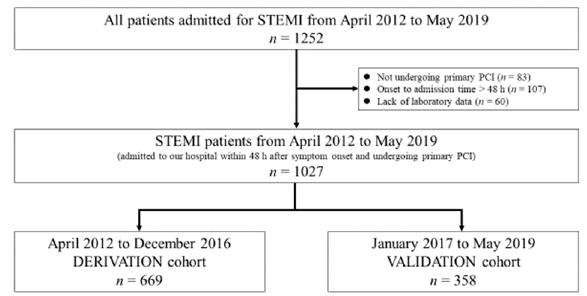
Figure 1. Flow diagram of patient enrollment in the study. PCI, percutaneous coronary intervention; STEMI, ST-segment elevation myocardial infarction.